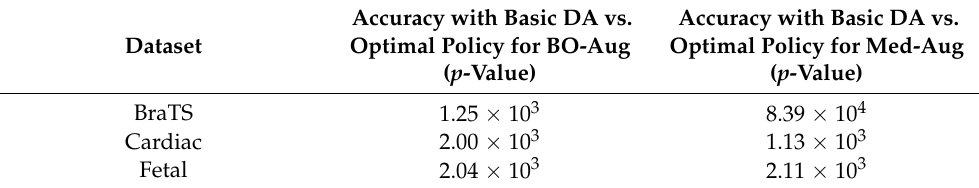
Table 4. Average p -values comparing performance of each model with different sets of DA using BIPOP-CMA-ES and BO-Aug. Accuracy with Basic DA vs. Dataset